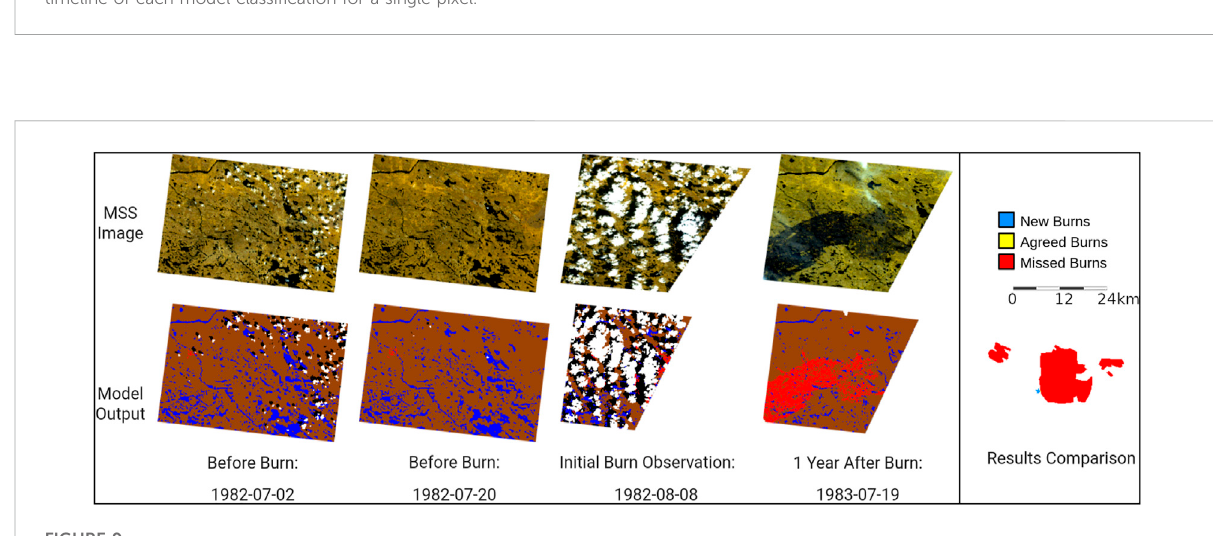
FIGURE 9 Results Detail G. The only MSS observation of a fi re that started on 1981 – 07-27 from within the study